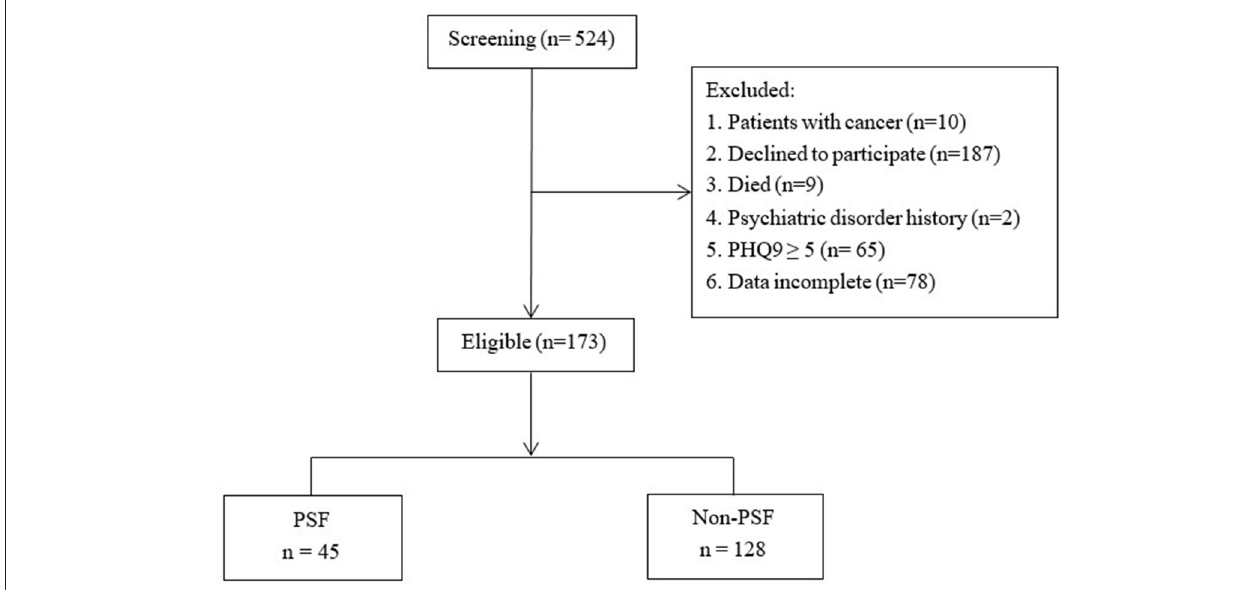
FIGURE 1 | The flow of participants. PSF, Post-stroke fatigue; PHQ-9, Patient Health